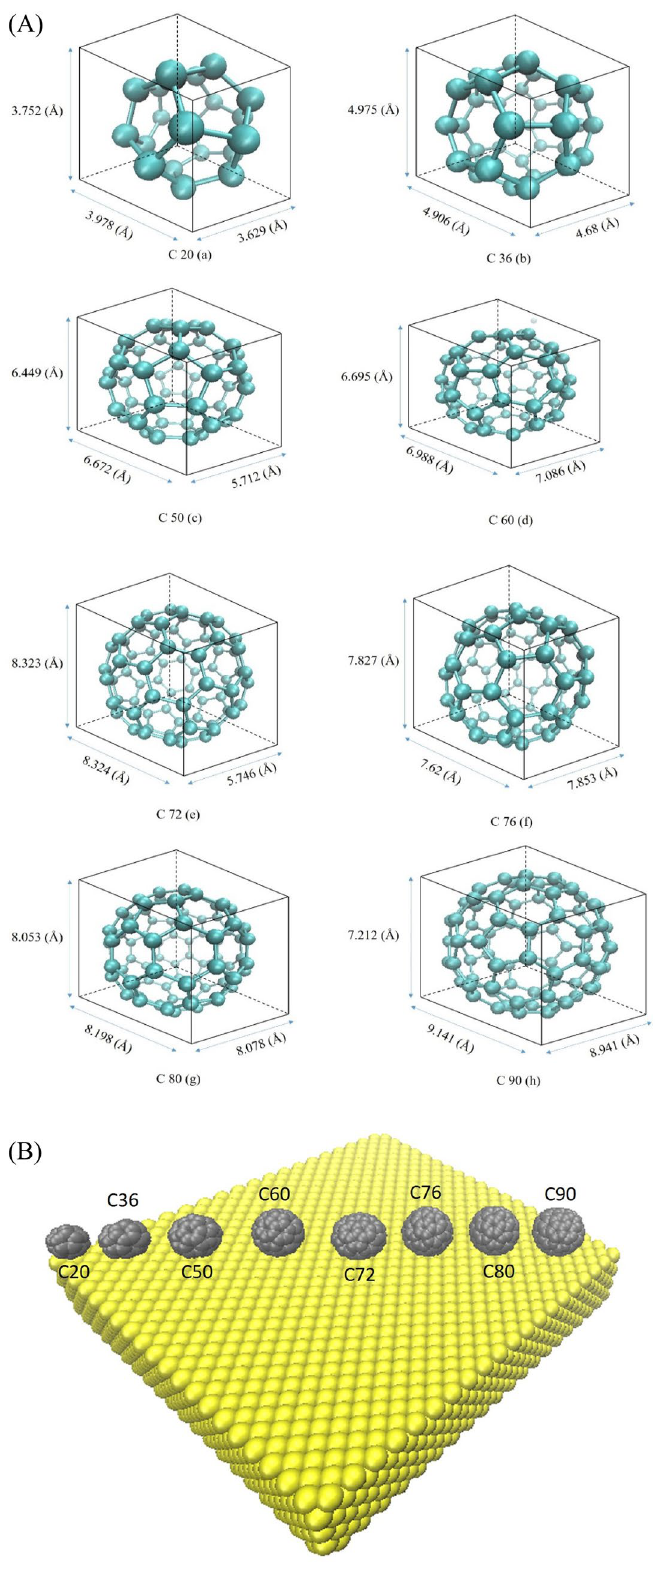
Figure 1. ( A ) The three-dimensional view of Different fullerenes simulated in this study which are C 20 (a), C 36 (b),